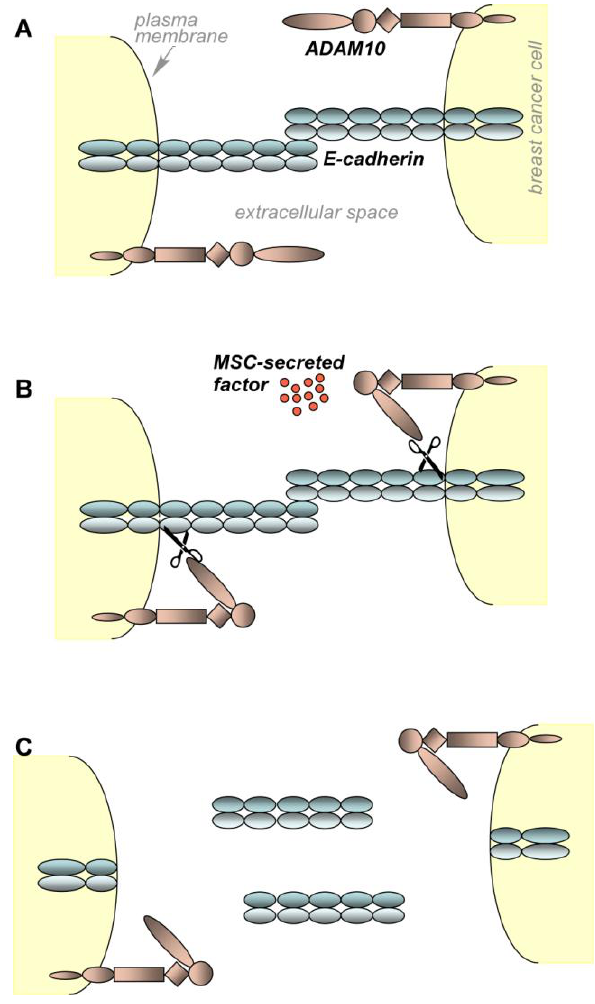
FIGURE 1. E-cadherin cell-cell adhesion of breast cancer cells (A) is weakened by a MSC-secreted factor that activates ADAM10 (B). Once detached from their neighboring cells, cells are able to migrate